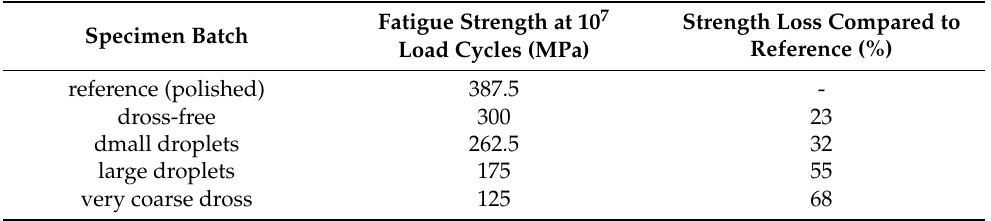
Figure 6. S-N curves for the representative dross geometries. Table 4. Fatigue strength of the representative dross geometries and their reduction in fatigue strength compared with the reference (polished).